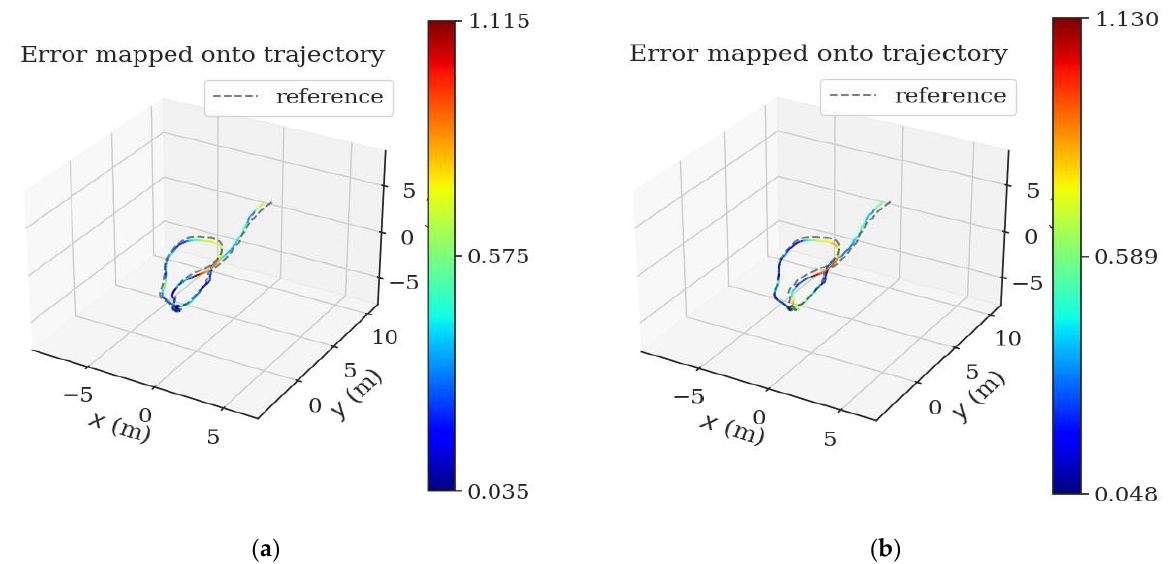
Figure 5. ( a ) is the trajectory error of VINS-MONO algorithm on sequence_03.bag dataset. ( b ) is the trajectory error of the optimized VINS-MONO on Sequence_03.bag dataset.